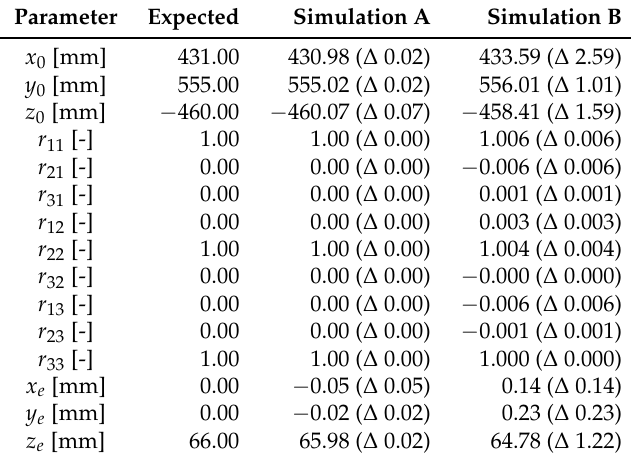
Table 3. Results of simulations for the X vector after identification.